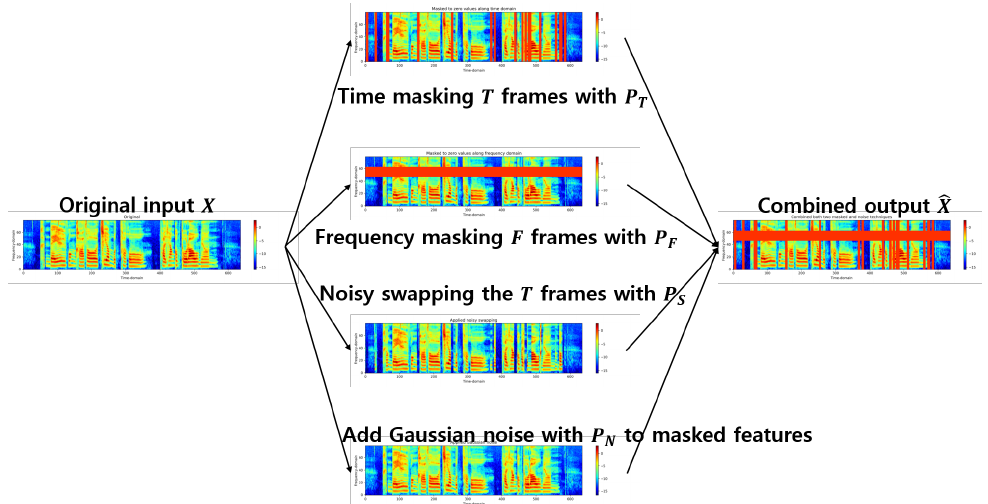
Figure 2. The overall flow of the proposed masking strategy has both the time–frequency mask and noise masking techniques. The masked part is presented in